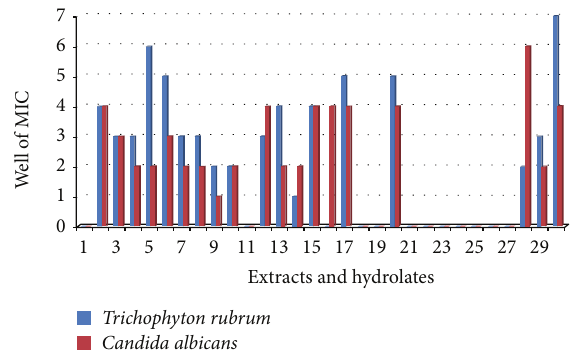
Figure 1: MICs of extracts against Tricophyton rubrum and Candida albicans . 1–30 = E01–E30. E02, E03, and E15 showed similar trends. E30wasthemostactiveagainst T.rubrum .MICs:1=1667 𝜇 g/mL,2= 556 𝜇 g/mL, 3 = 185 𝜇 g/mL, 4 = 62 𝜇 g/mL, 5 = 21 𝜇 g/mL, 6 = 7 𝜇 g/mL, 7 = 2 𝜇 g/mL, and - = no